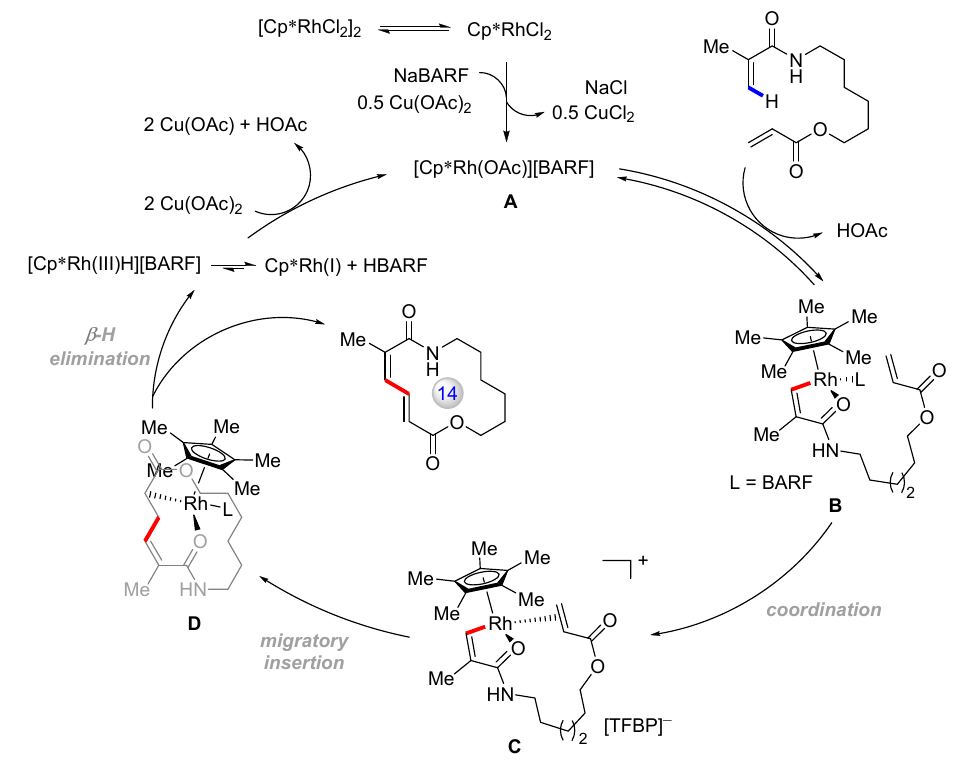
Figure 4. Proposed mechanism for the Cp*Rh(III) ‐ catalyzed intramolecular alkenyl sp 2 C–H activation–macrocyclization [56].